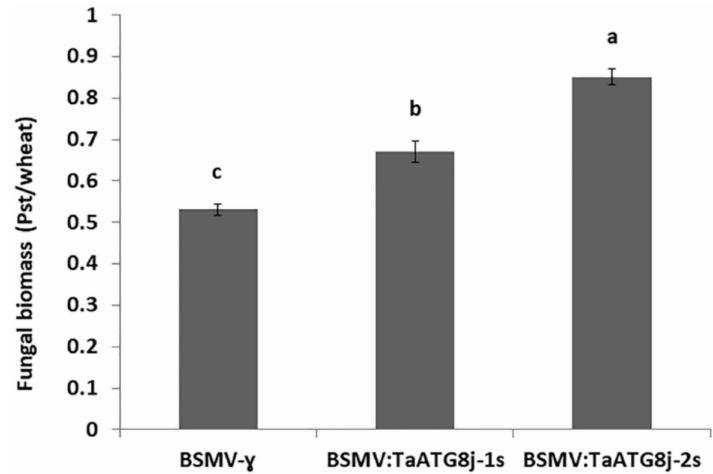
Figure 10. DNA biomass assay in TaATG8j -silenced plants challenged with the avirulent Pst pathotype CYR23. Two standard curves were generated for the accurate measurement of Pst and wheat DNA. Quantification cycle (Cq) values are plotted against the initial copy number of template DNA (10 4 , 10 5 , 10 6 , 10 7 , 10 8 , and 10 9 ). Genomic DNA of Su11, infected with urediniospore of Pst pathotype CYR23, was used to generate the standard curves. Fungal biomass was measured by qRT-PCR on the extracted total genomic DNA from wheat leaves infected with CYR23 at 18 dpi. The ratio of the total fungal to total wheat DNA was calculated using the TaEF-1 α and Pst-EF genes for normalization. The letters a, b, c indicates the significant difference using LSD test among biomass in BSMV: γ , BSMV:TaATG8j-1s and